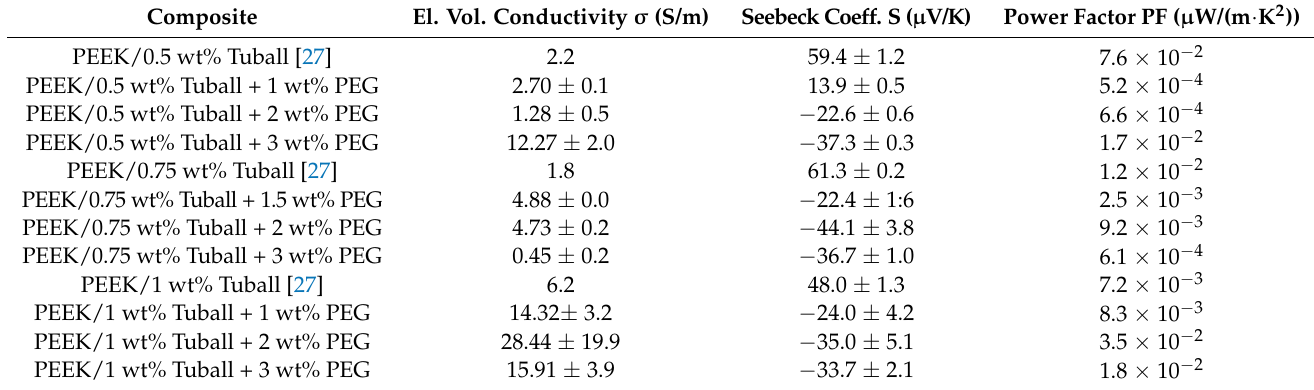
Table 3. TE properties of PEEK composites with SWCNT Tuball and PEG in different quantities.